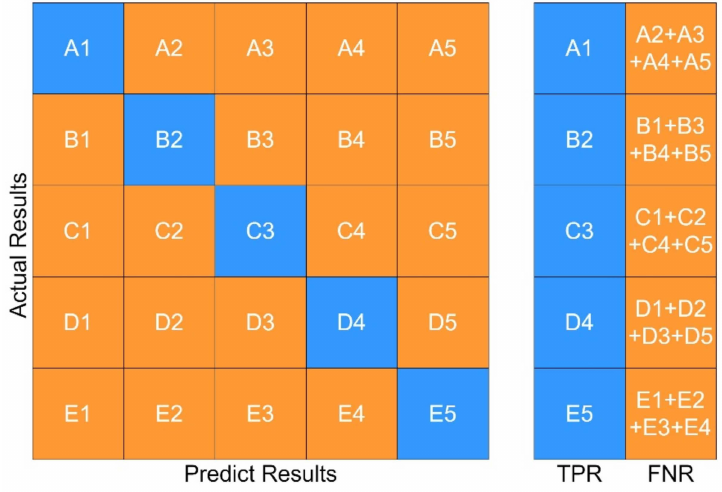
Figure 12. Confusion Matrix.